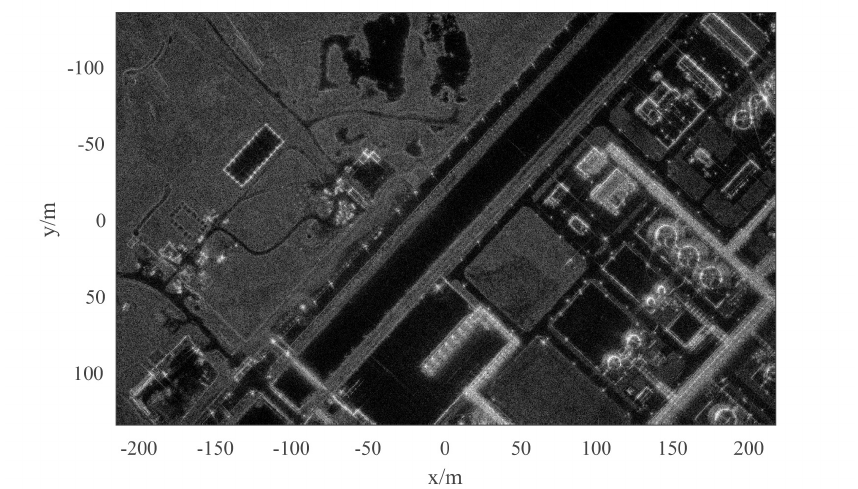
Figure 5. Coherent complex image of C − band data.